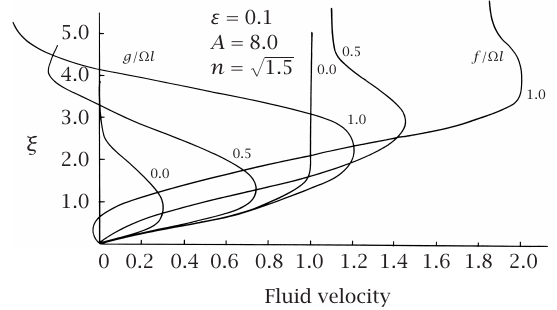
Figure 3.9 . Variations of f/ Ω l and g/ Ω l for different values of the blowing parameter and in presence of A , the magnitude of fluctuation in blowing